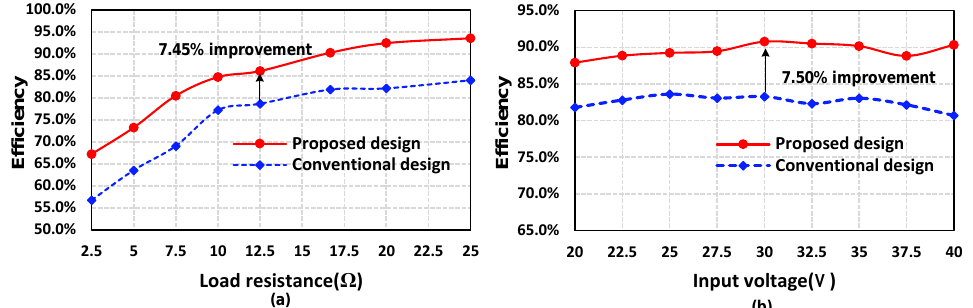
Figure 16. Prototype efficiency under different working conditions. ( a ) Efficiency with respect to load